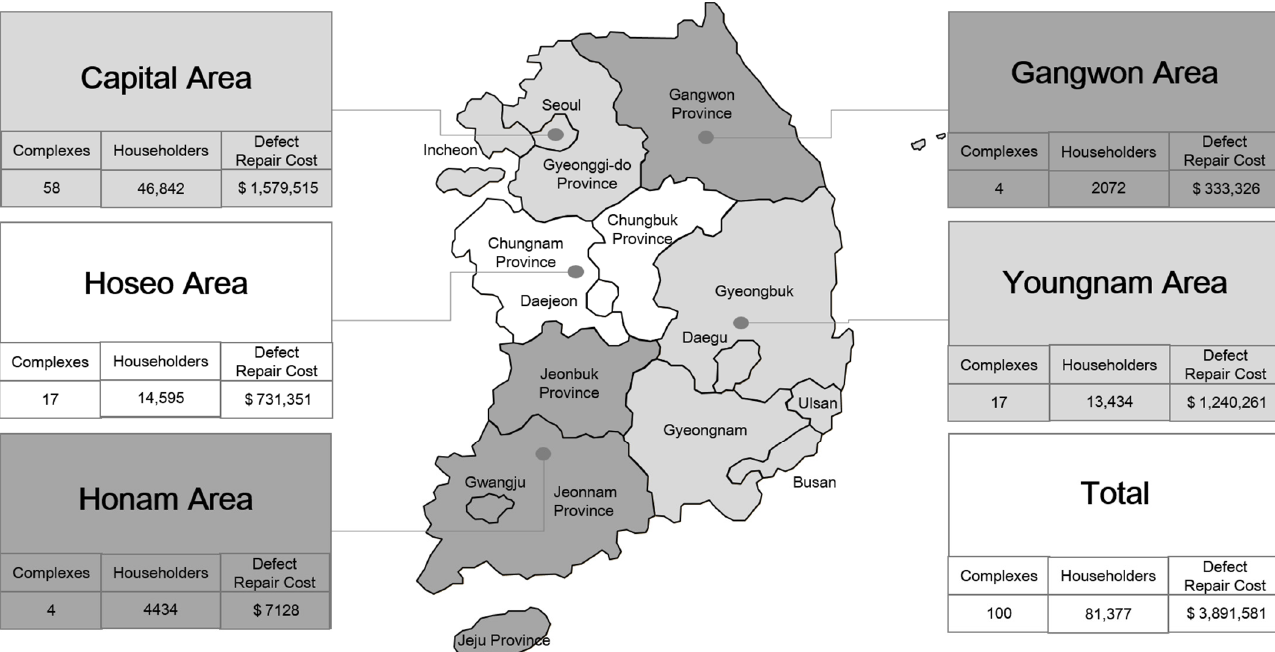
Figure 1. Case distribution.